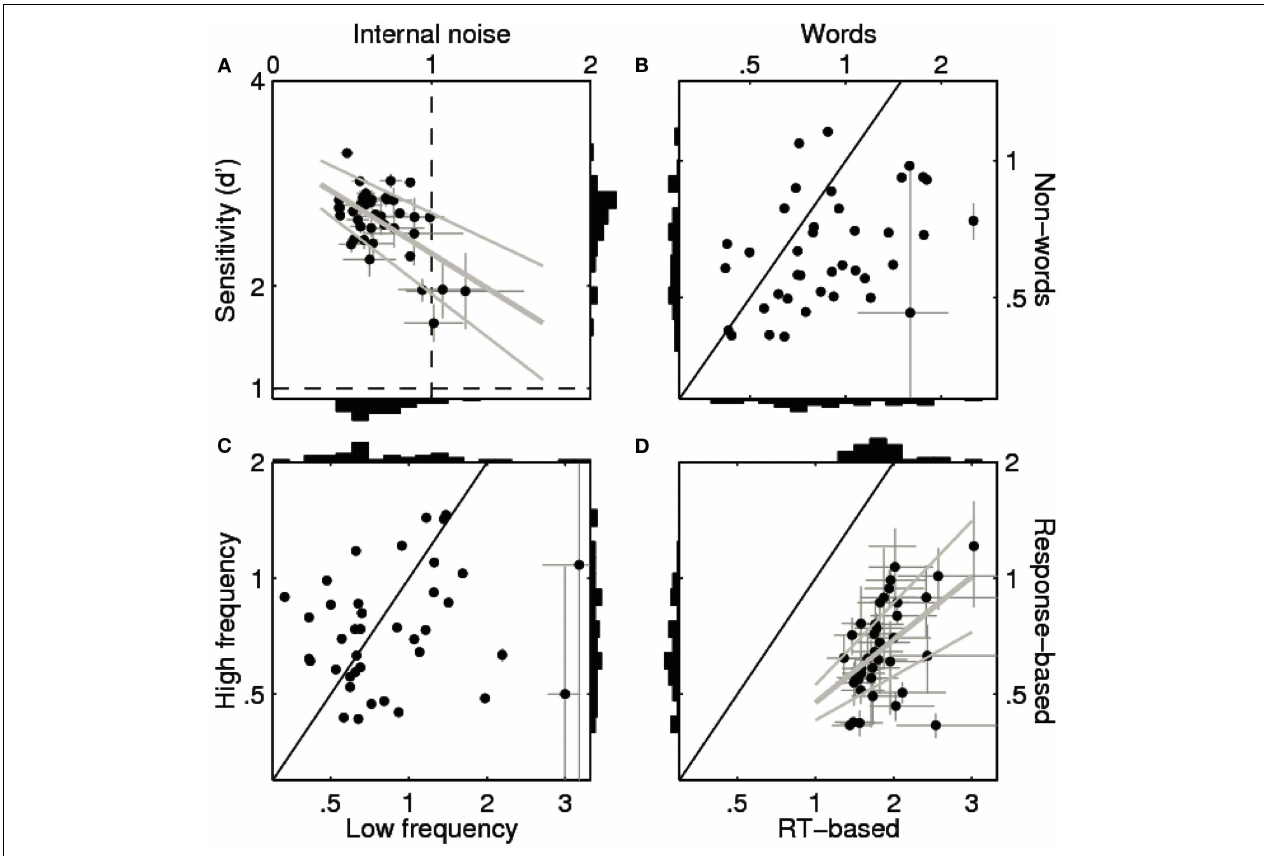
internal noise computed from low-frequency word trials only ( x axis) against internal noise from high-frequency word trials only ( y axis). Solid black lines mark identity. Error bars show ± 1SE (smaller than symbol when not visible). (A,D) Include best linear fit (thick gray line) ± 1SE (thin gray lines). (D) Shows internal noise computed from reaction time measurements ( x axis) against internal noise computed from response choice data 2 ( y